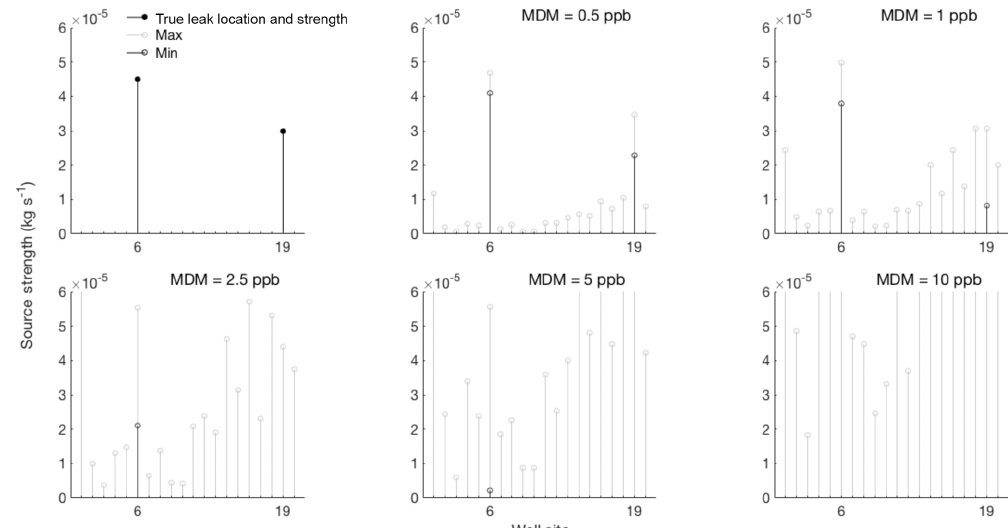
Figure 6. Top left panel shows well site numbers ( x axis) and corresponding “true” leak rates ( y axis), and remaining panels show NZMB results ( y axis) for each well site location ( x axis) with synthetic observations perturbed with model–data mismatch (MDM) noise shown, for the eight-beam case. Light gray (black) open circles show locations and strengths of the maximum (minimum) of 1000 bootstrap operations. Minimum values of zero are not